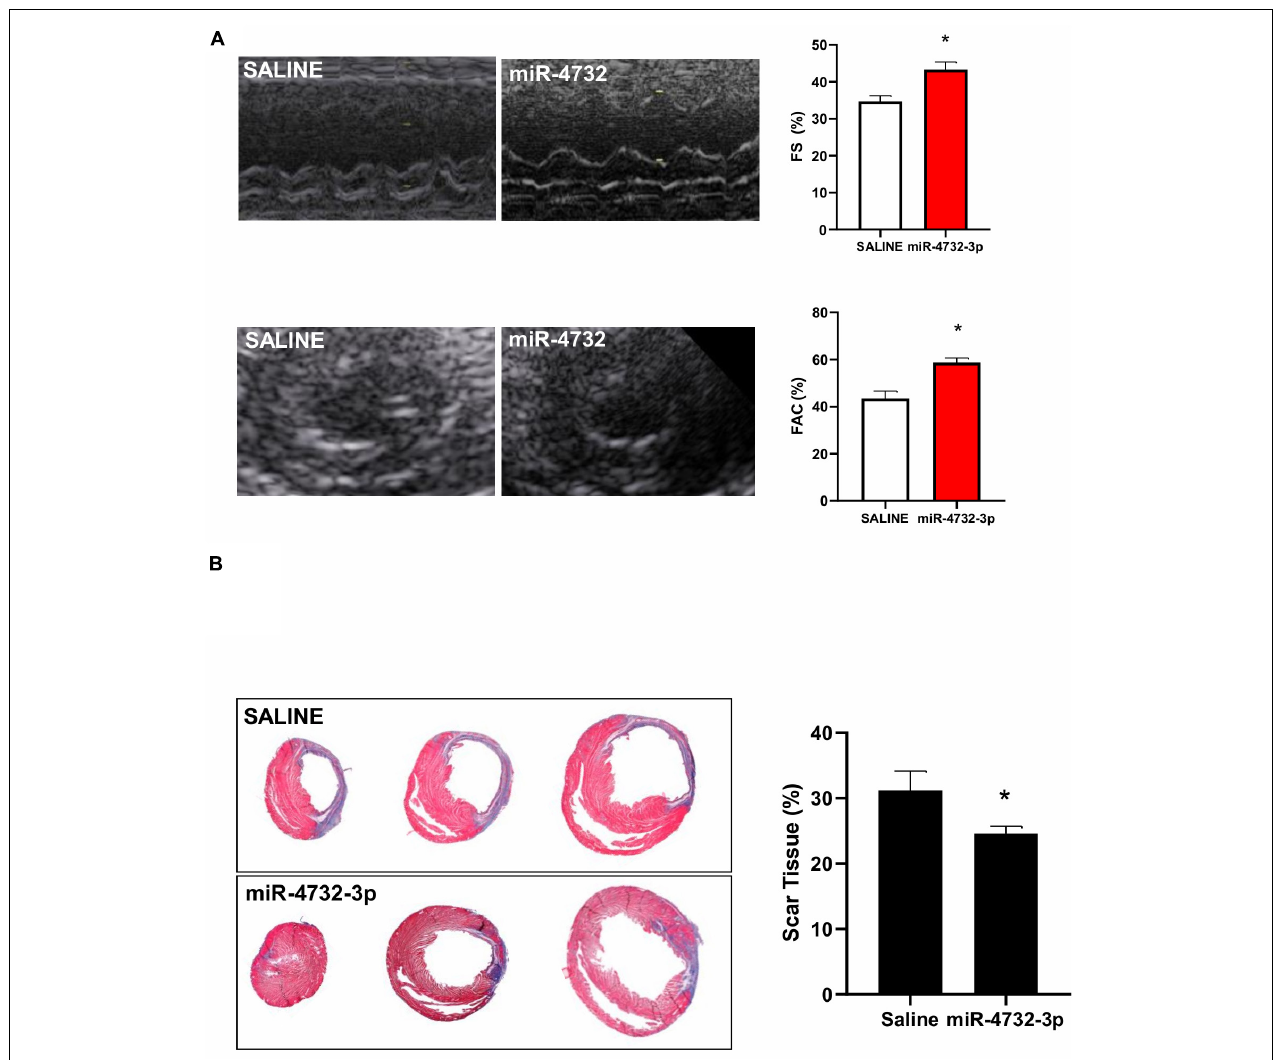
FIGURE 6 | Effect of EVs and miRNA 4732-3p in infarcted nude rats (A) improvement of LV function in miR-4732-3p-treated animals. Representative echocardiographic images of M-mode and two-dimensional systolic frame showing differences in wall motion in one animal from saline ( n = 6), and miR-4732-3p ( n = 8) groups. Quantified values of fractional shortening (FS) area fractional change (FAC) are given. Data are expressed as mean ± SEM (* p < 0.05 in both panels). (B) Fibrotic area (blue color) in the LV was calculated from Masson’s Trichrome stained sections. Animals were euthanized 4 weeks post-transplantation. Values are the mean ± SEM (* p <